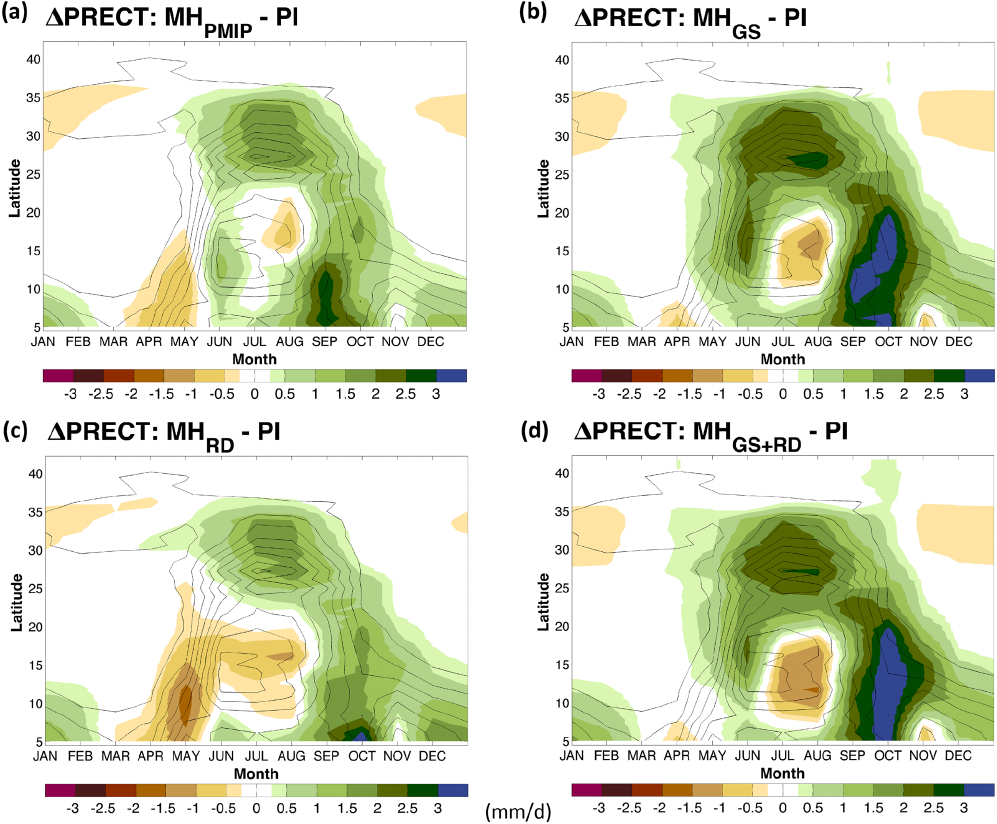
Figure 3. Changes in climatological seasonal cycle of zonal precipitation (PRECT; mm/d) between 65 and 95 ◦ E for (a) the mid-Holocene- only orbital forcing (MH PMIP ); (b) the Sahara greening (MH GS ); (c) the dust-only reduction (MH RD ); and (d) the Sahara greening and dust reduction (MH GS + RD ) experiments relative to the PI reference simulation. The contour lines show the climatological zonal precipitation of the PI experiment (1mm/d